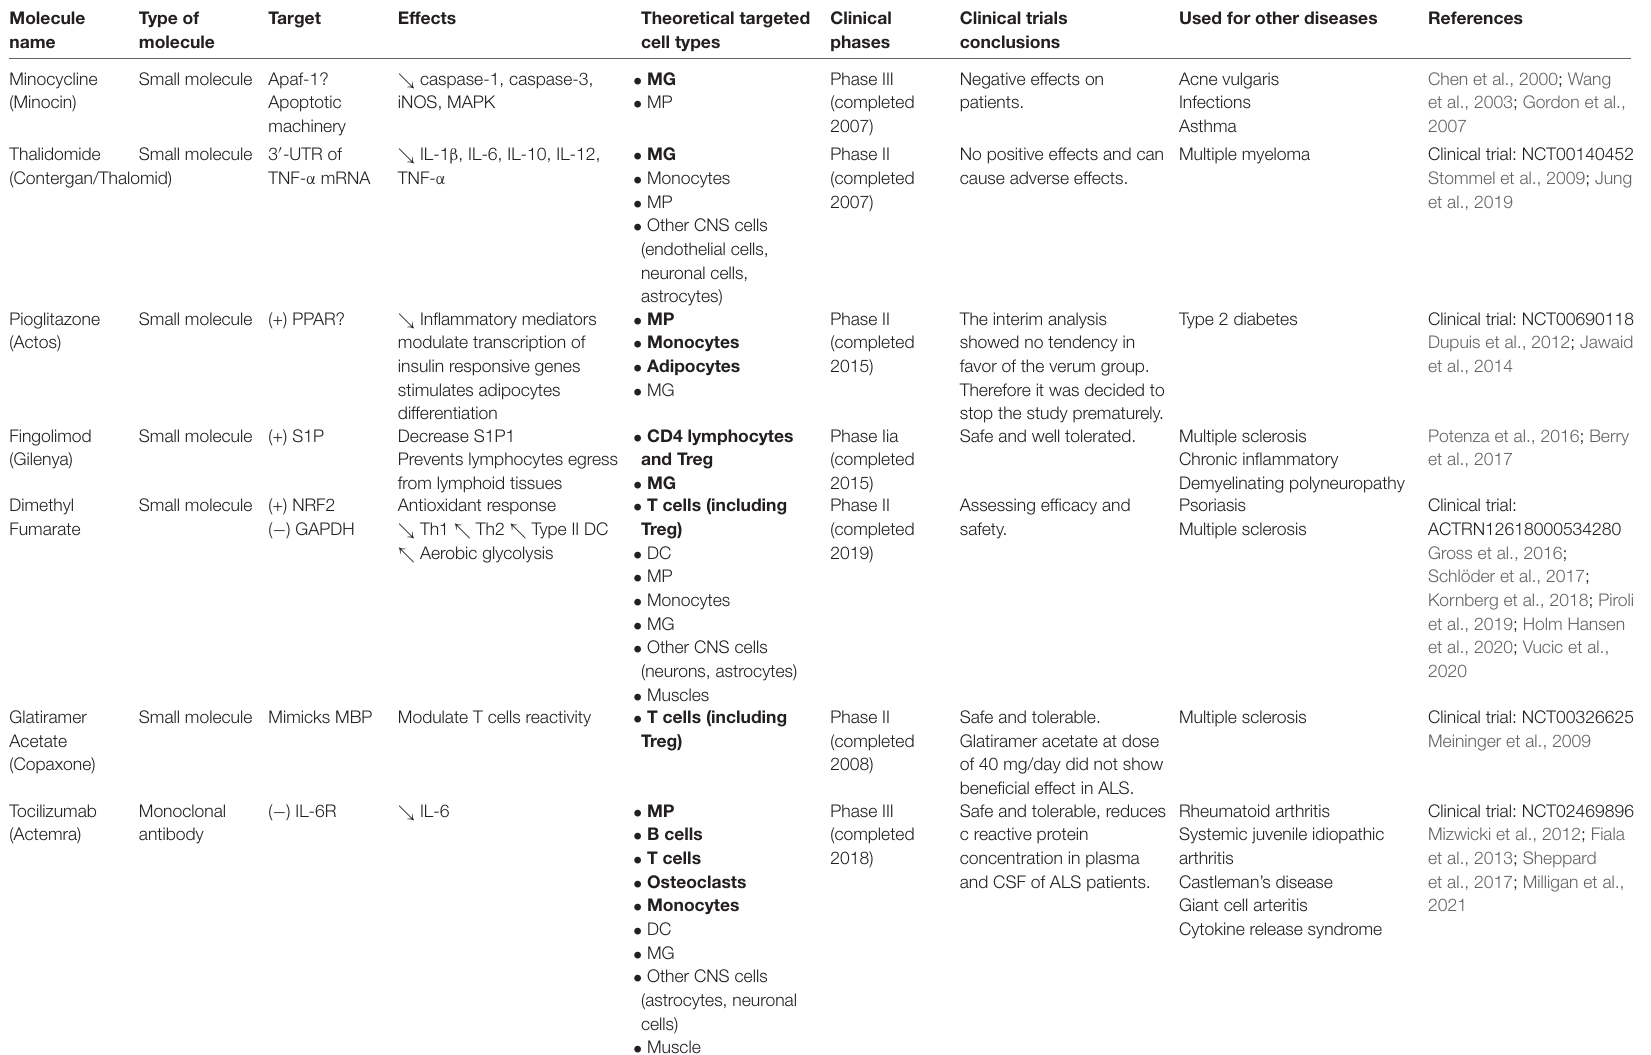
TABLE 4 | List of the different immune modulatory therapeutic approaches clinical trials. Molecule